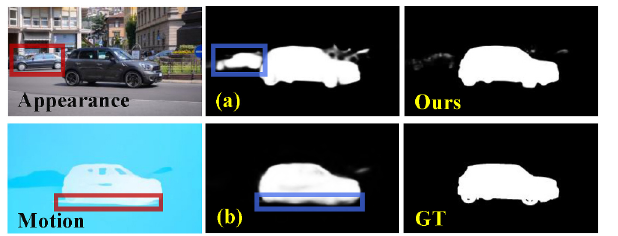
Fig. 2 Results using the simplex strategy (i.e., (a) appearance- refined motion and (b) motion-refined appearance) and our full-duplex strategy, which offers a collaborative way of using appearance and motion cues under mutual restraints . It thus provides more accurate structural details and alleviates the short-term feature drift issue